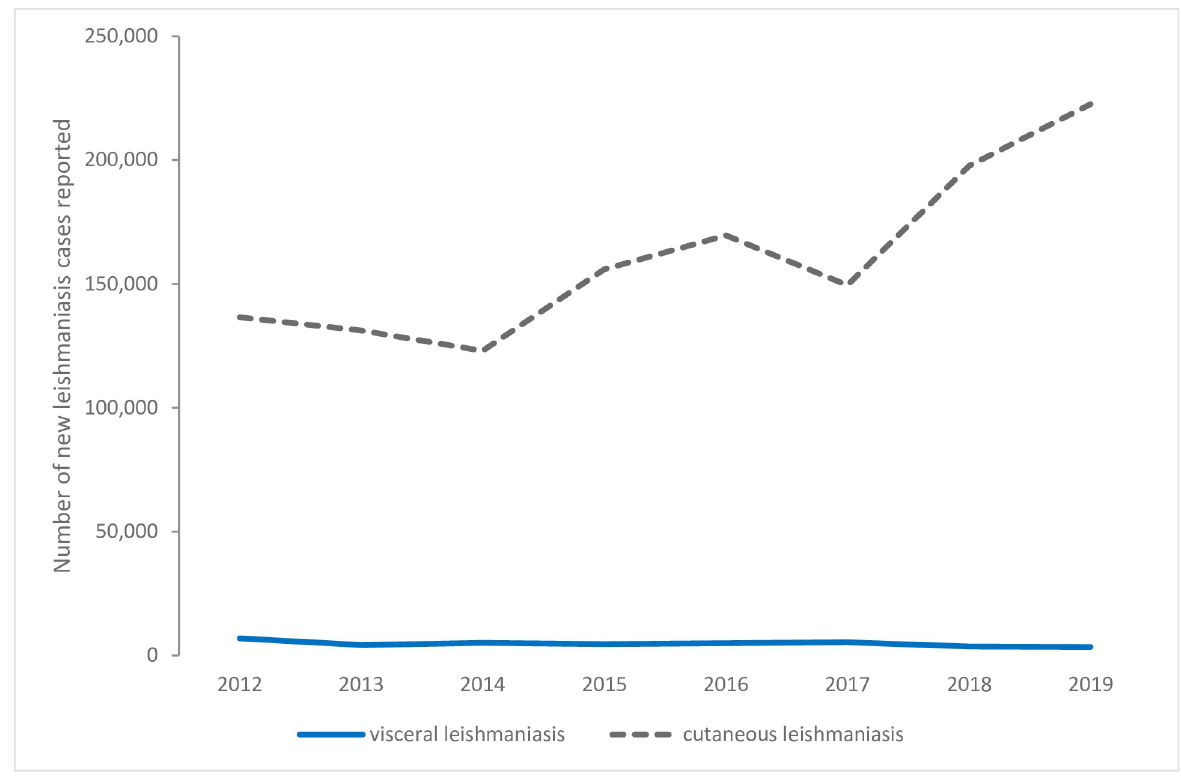
Fig 2. The number cutaneous and visceral leishmaniasis cases reported in the Eastern Mediterranean Region, 2012–2019, Global Health Observatory data repository (https://apps.who.int/gho/data/node.main.A1638?lang=en).